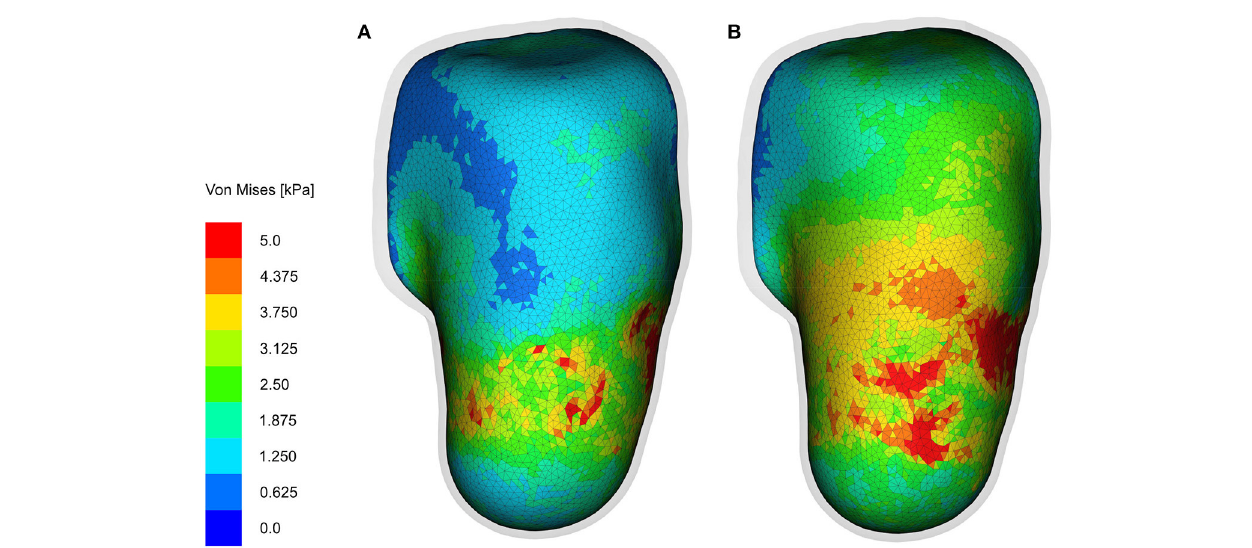
FIGURE 12 | Interface stresses. The interface stresses on the skin/fat layer at the end of 2-h bipedal stance analysis are shown (in the anterio-posterior viewing direction) here. (A,B) Show the Von Mises stresses in the fused- and individual-muscle models, respectively. For the sake of clarity, the socket is hidden, and the liner is rendered transparent to show the stresses on the underlying skin/fat layer. The stress legend is common for both the models, and is capped at 5 kPa to better illustrate the stress zones.